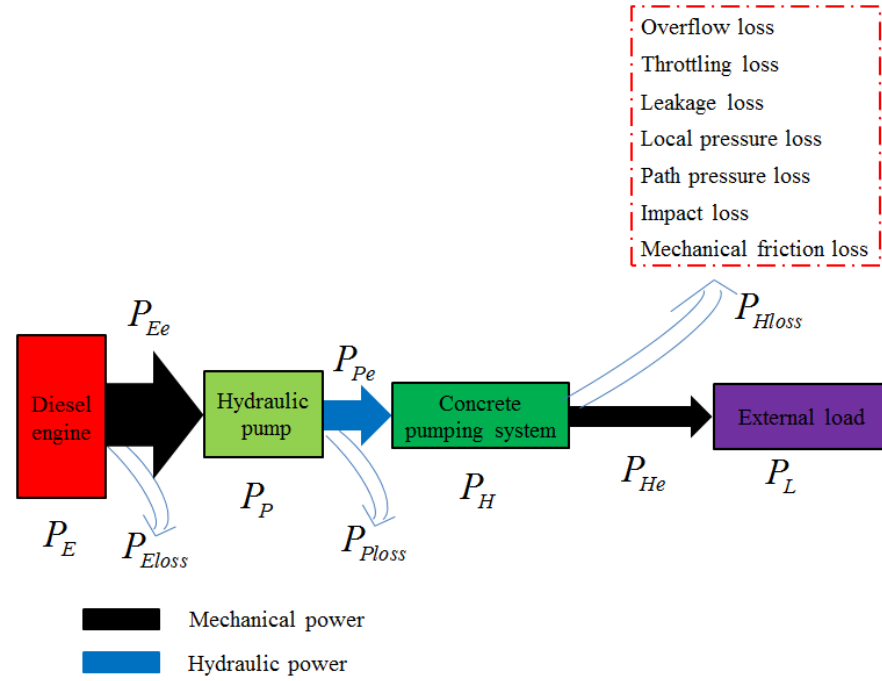
Figure 7. Energy flow route of trailer concrete pump.